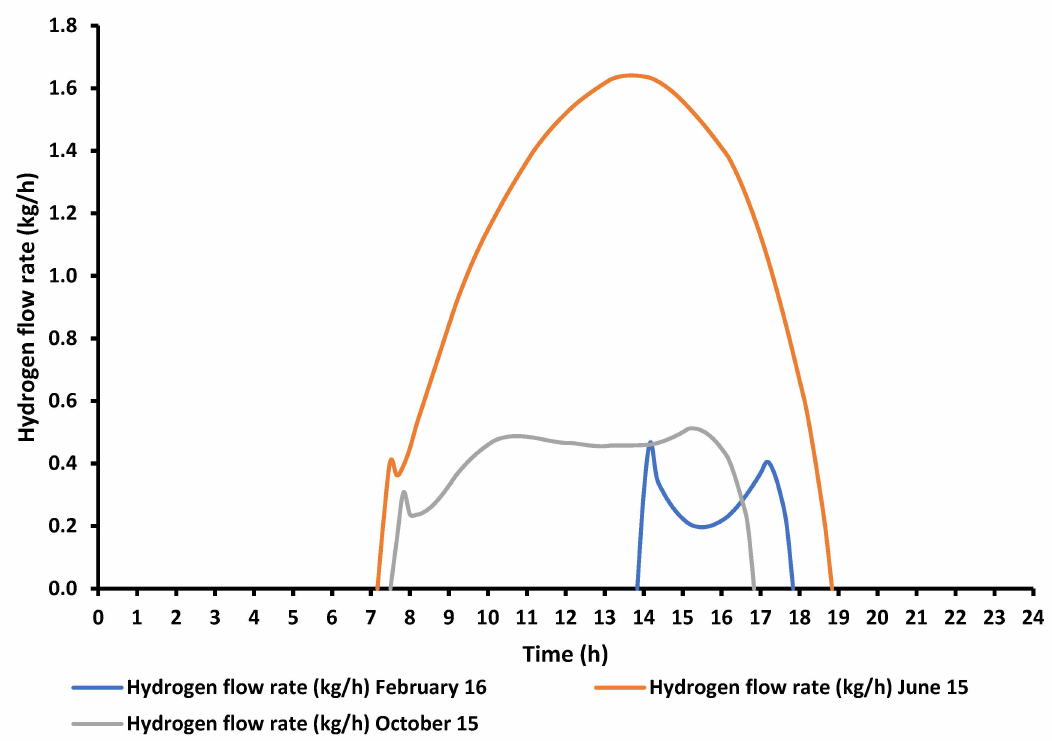
Figure 18. Hydrogen production rate during the day.